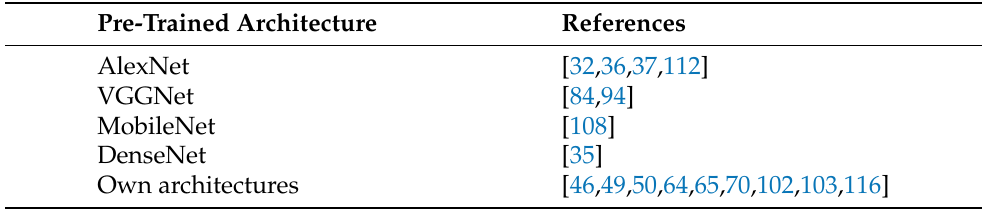
Table 12. The pre-trained architectures used for fine tuning in the same domain with ELM reported in the primary